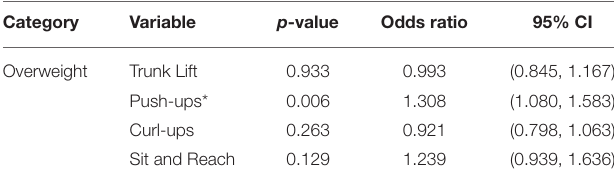
( Table 10B ).There were no significant differences ( p > 0.05)